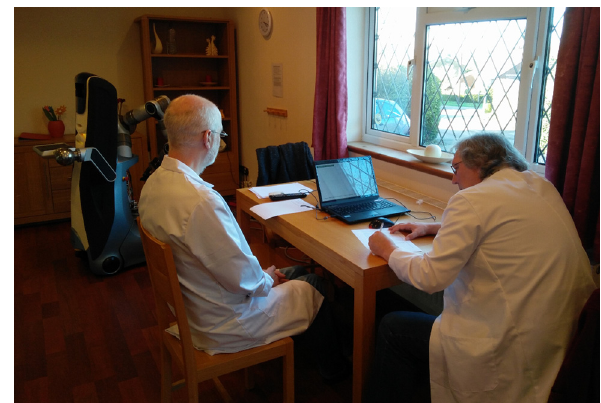
Figure 8: Training in progress. The experimenter is facing the window, the participant is facing the laptop computer with the TEACH M E system running. The Care - O - bot3 ® robot is present in the